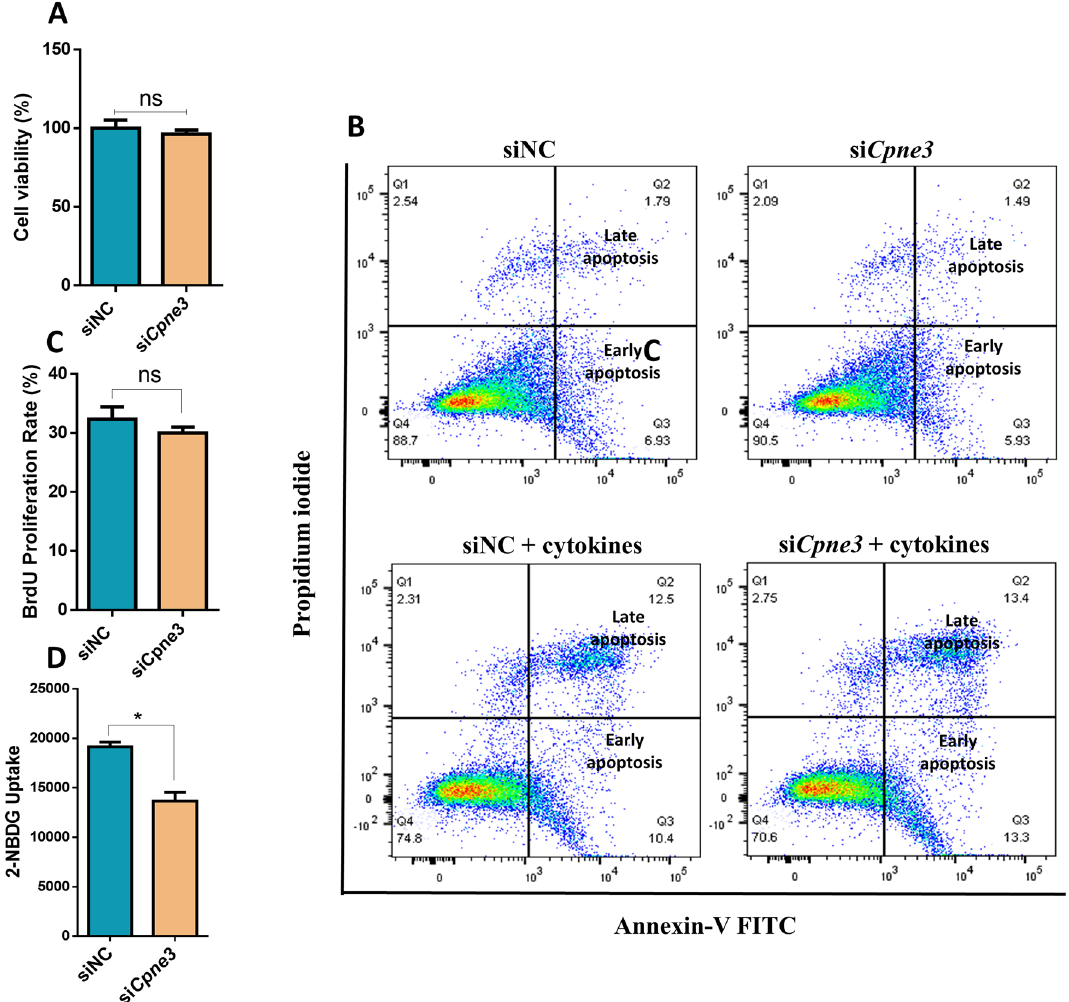
Figure 3. Influence of Cpne3 -silencing on apoptosis and glucose uptake levels. ( A ) Percentage of cell viability was determined by MTT assay in Cpne3 -silenced cells compared to control cells. ( B ) Analysis of apoptosis level in Cpne3 -silenced INS-1 cells or negative control in the absence (upper panels) or presence (lower panels) of cytokine stimulation as analyzed by flow cytometry. ( C ) Evaluation of cell proliferation in Cpee3-silenced cells compared to control cells. ( D ) Evaluation of glucose uptake efficiency in Cpne3 -silenced cells compared to control cells. Data are obtained from 3 independent experiments. Bars represent mean ±